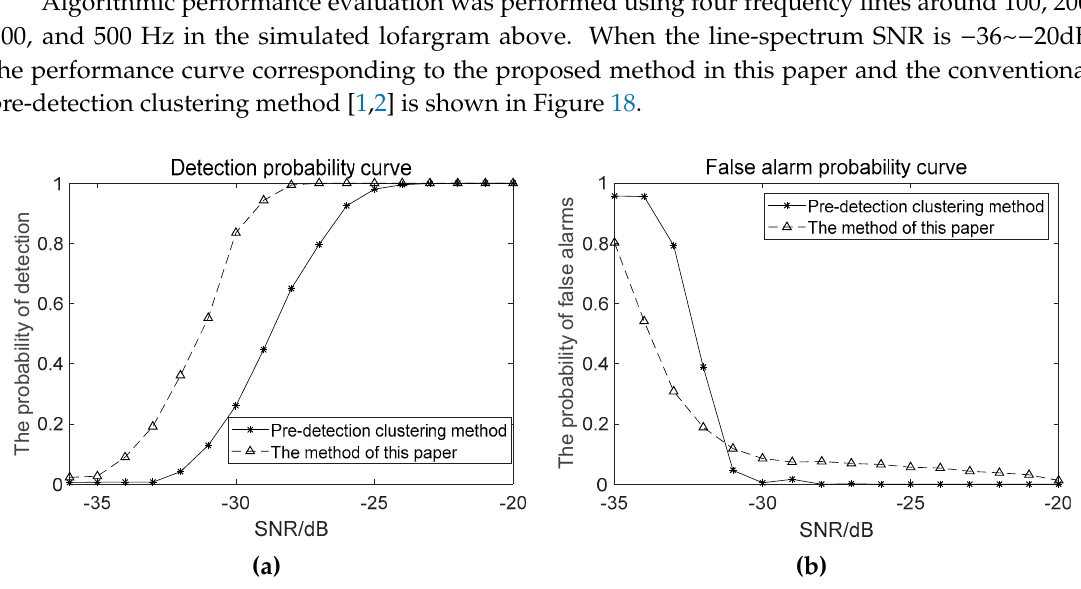
Figure 18. Performance comparison between the proposed method in this paper and pre-detection clustering method: ( a ) The detection probability curve; ( b ) The false alarm probability curve.